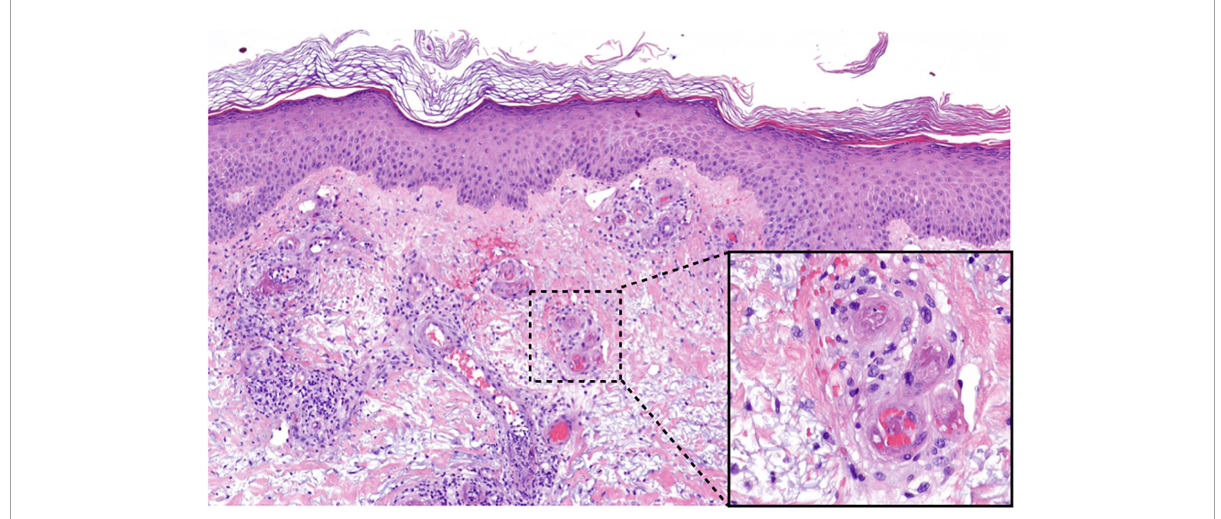
FIGURE2 Histology of LV lesions. Fibrinoid thrombi and erythrocyte sludge in small vessels of the upper dermis with perivascular lymphocytes and extravasated erythrocytes (HE, magnification 50 × , detail 400 × ).